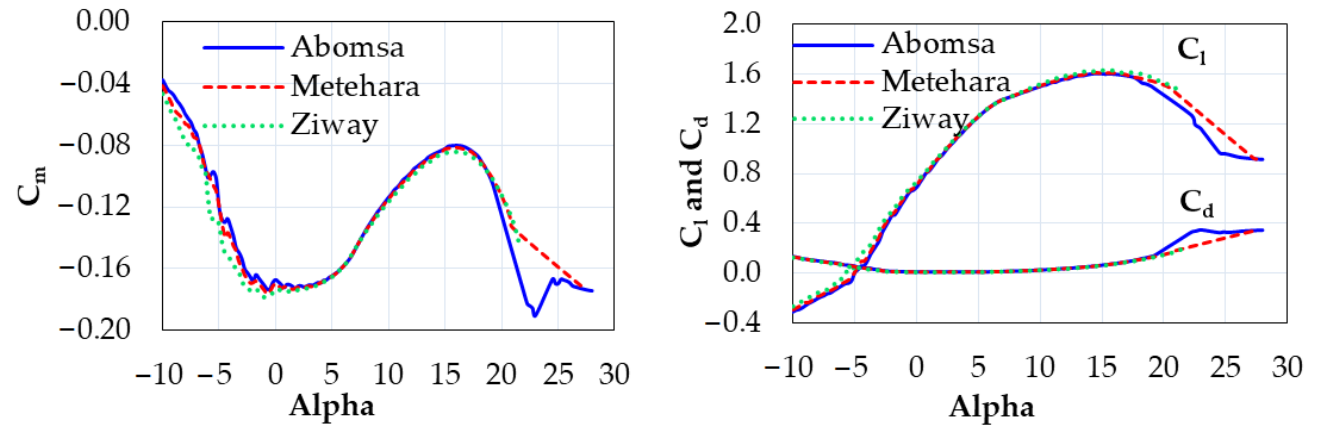
Figure 9. The C m , C l , and C d of SG6043 data for Abomsa, Metehara, and Ziway.